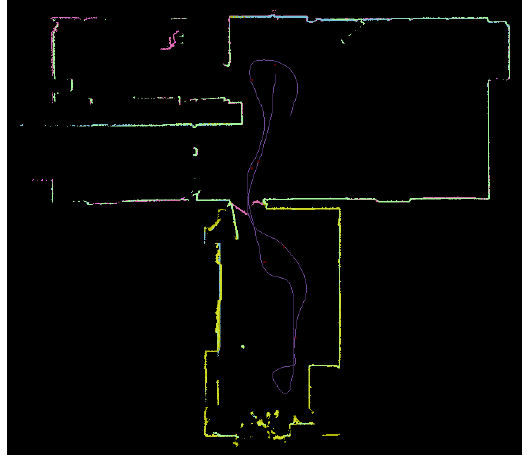
Figure 9. iMMS processed SLAM solution trajectory loop of